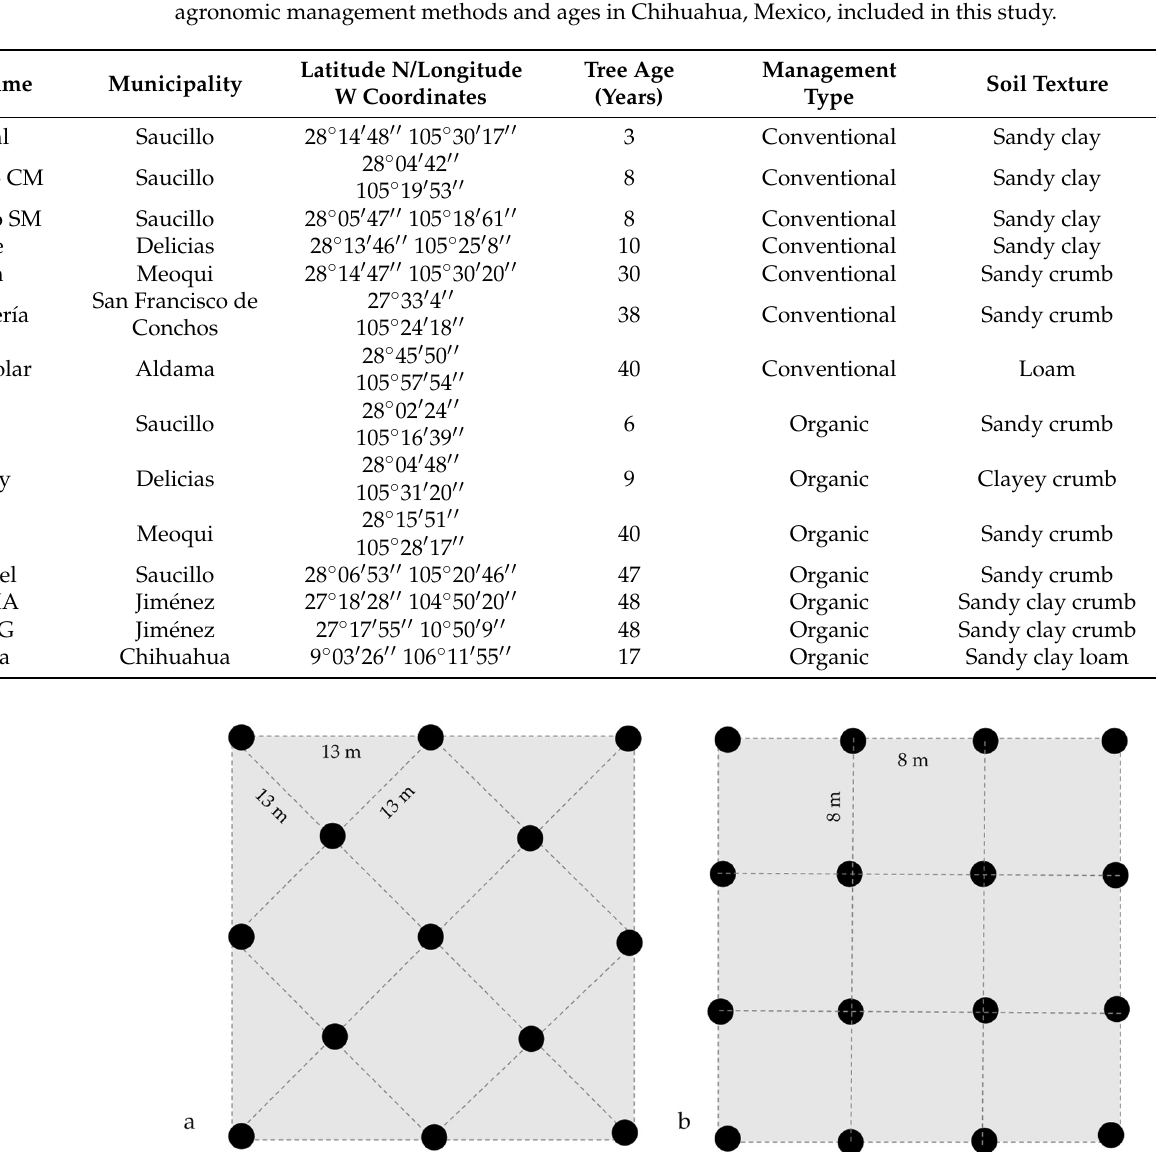
Figure 1. Pecan orchard planting frame. ( a ) Trees in staggered pattern and ( b ) trees in real frame.